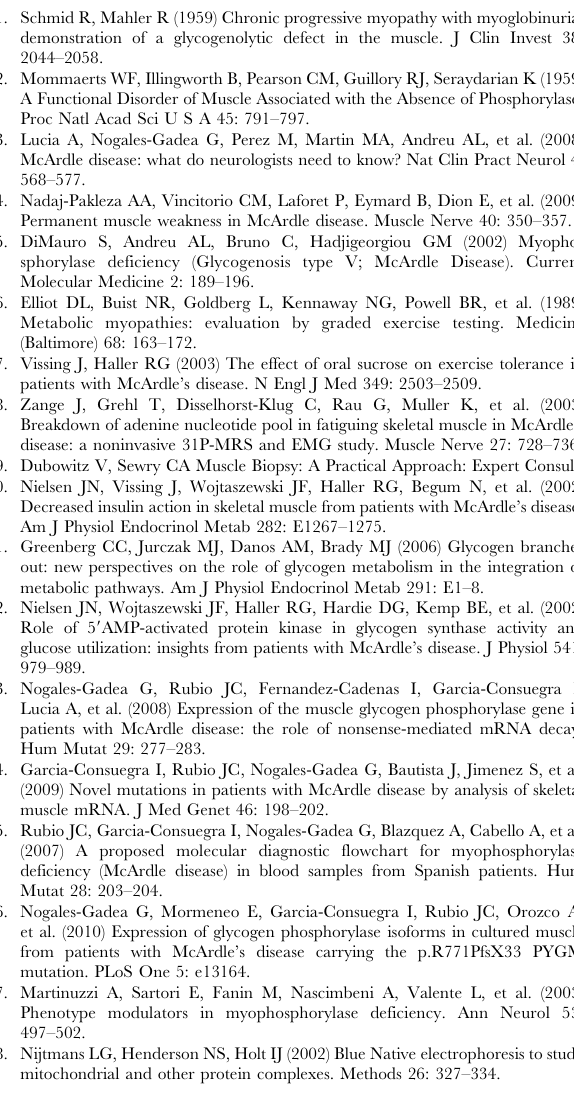
Table S1 Genes studied in the customized low density array. The genes of study are classified in groups depending on their role in muscle function: 1= metabolism; 2 =membrane transport; 3 = mitochondrial function/biogenesis and dynamics; 4= main- tainance of cytoskeleton; 5 = contractile function; 6= control of muscle growth; 7= neuromuscular transmission; 8 = anti-stress protection; 9 =inflammation; 10= cell death; 11 =calcium